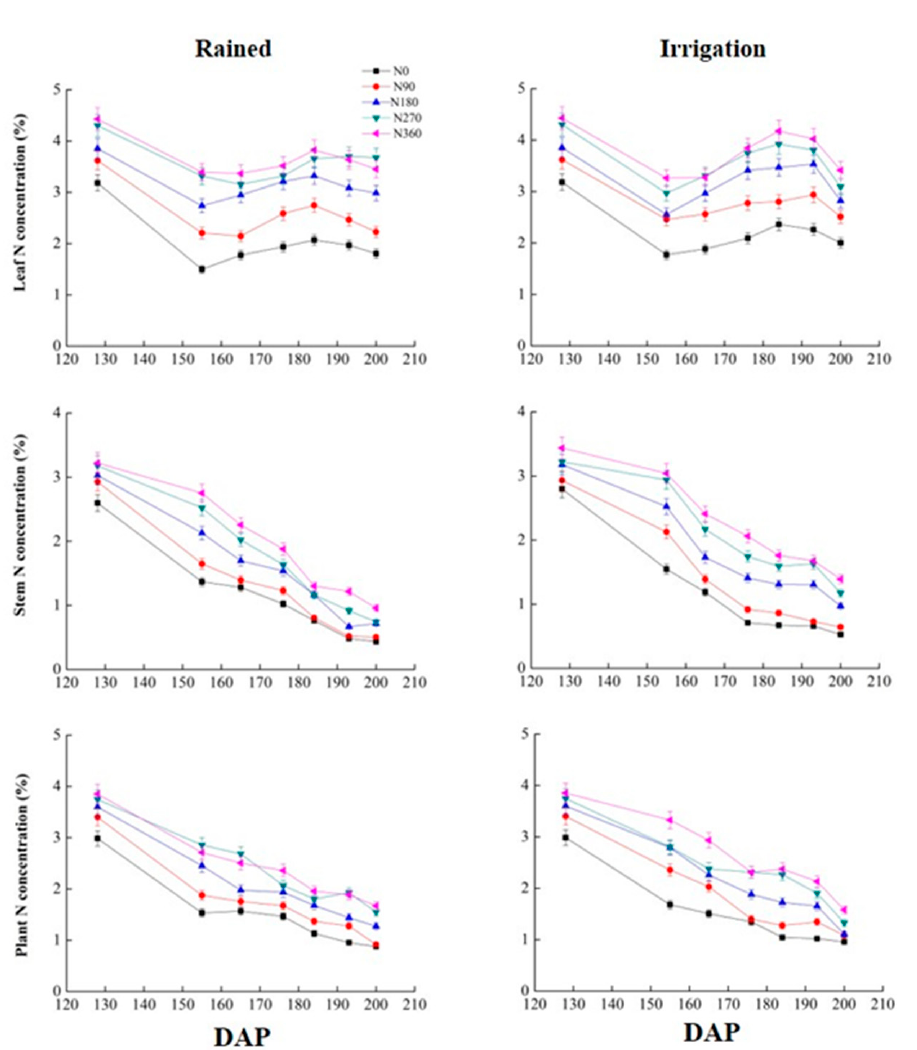
Figure 2. E ff ects of N application rates on the N concentration of wheat under di ff erent irrigation Figure 2. Effects of N application rates on the N concentration of wheat under different irrigation conditions. DAP: days after planting. The datasets are from Exp. conditions. DAP: days after planting. The datasets are from Exp. 2.